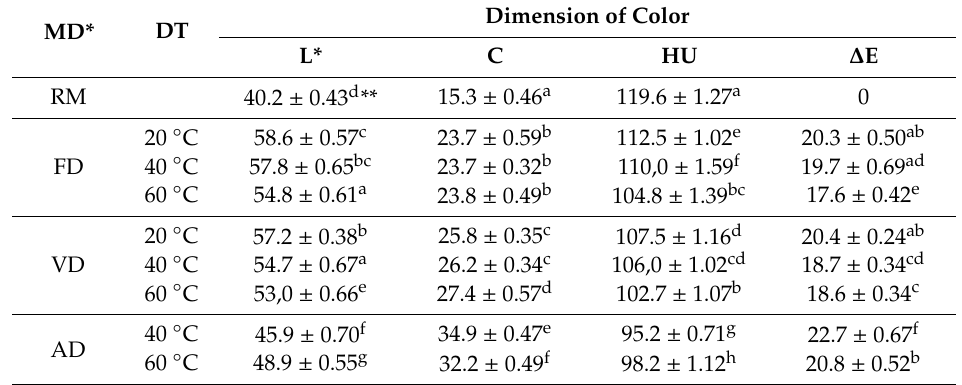
Table 8. E ff ect of the drying method on the color parameters of leaves from Moldavian dragonhead.